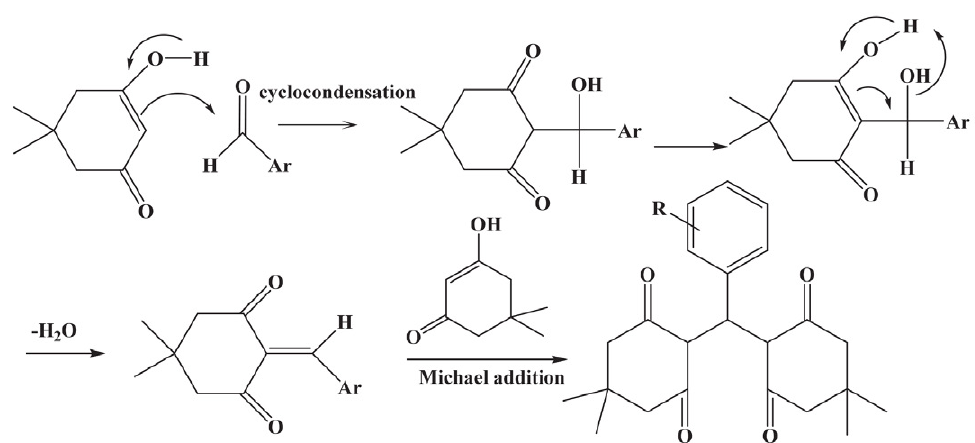
Figure 2. Synthesis of 2,2’-(arylmethylene)bis(5,5-dimethyl-2-cyclohexane-1,3-dione)